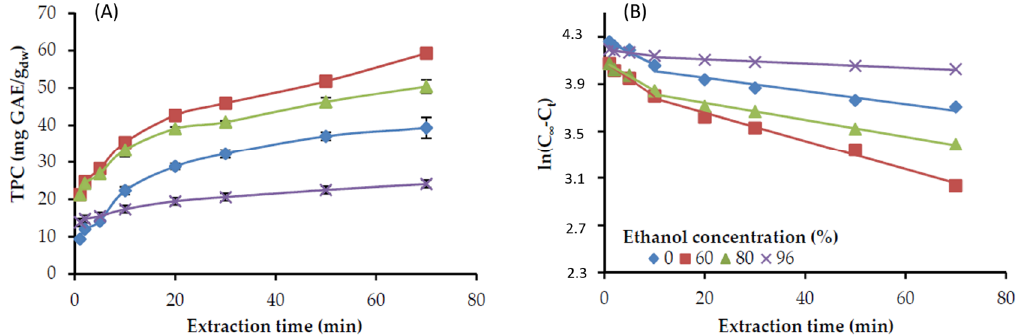
Figure 1. Phenolic compounds extraction from distilled, ground rosemary leaves at di ff erent ethanol concentrations in the aqueous solution, 22 ◦ C, and the solid-to-liquid ratio of 1:20 g / mL. ( A ) Experimental values of total phenols recovery (TPC) versus extraction time; ( B ) the factor ln(C ∞ − C t ) versus the extraction time, approximation curves based on a di ff usion model, according to Equation (1).